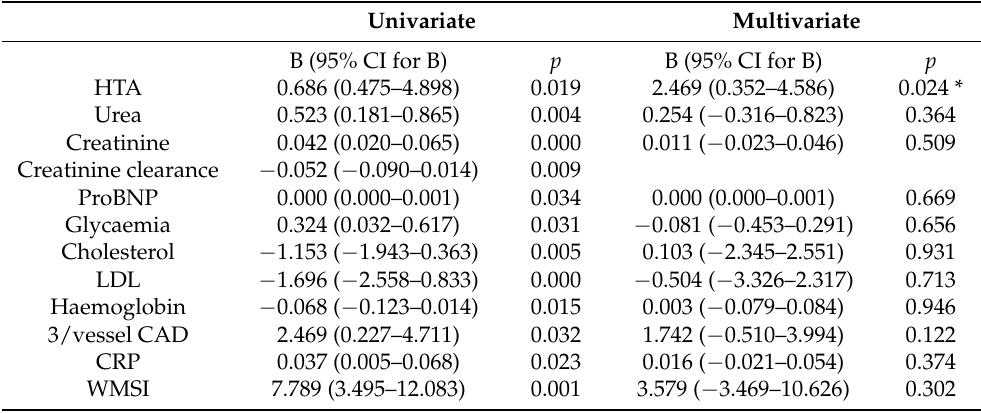
Table 5. Univariate and multivariate regression analysis demonstrating the relationship between baseline characteristics and galectin-3 concentration on day 1in